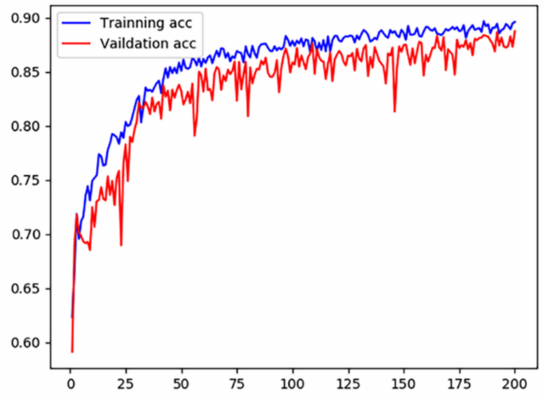
Figure 5. Variation of ACC in the training set and validation set of AttNeSt.